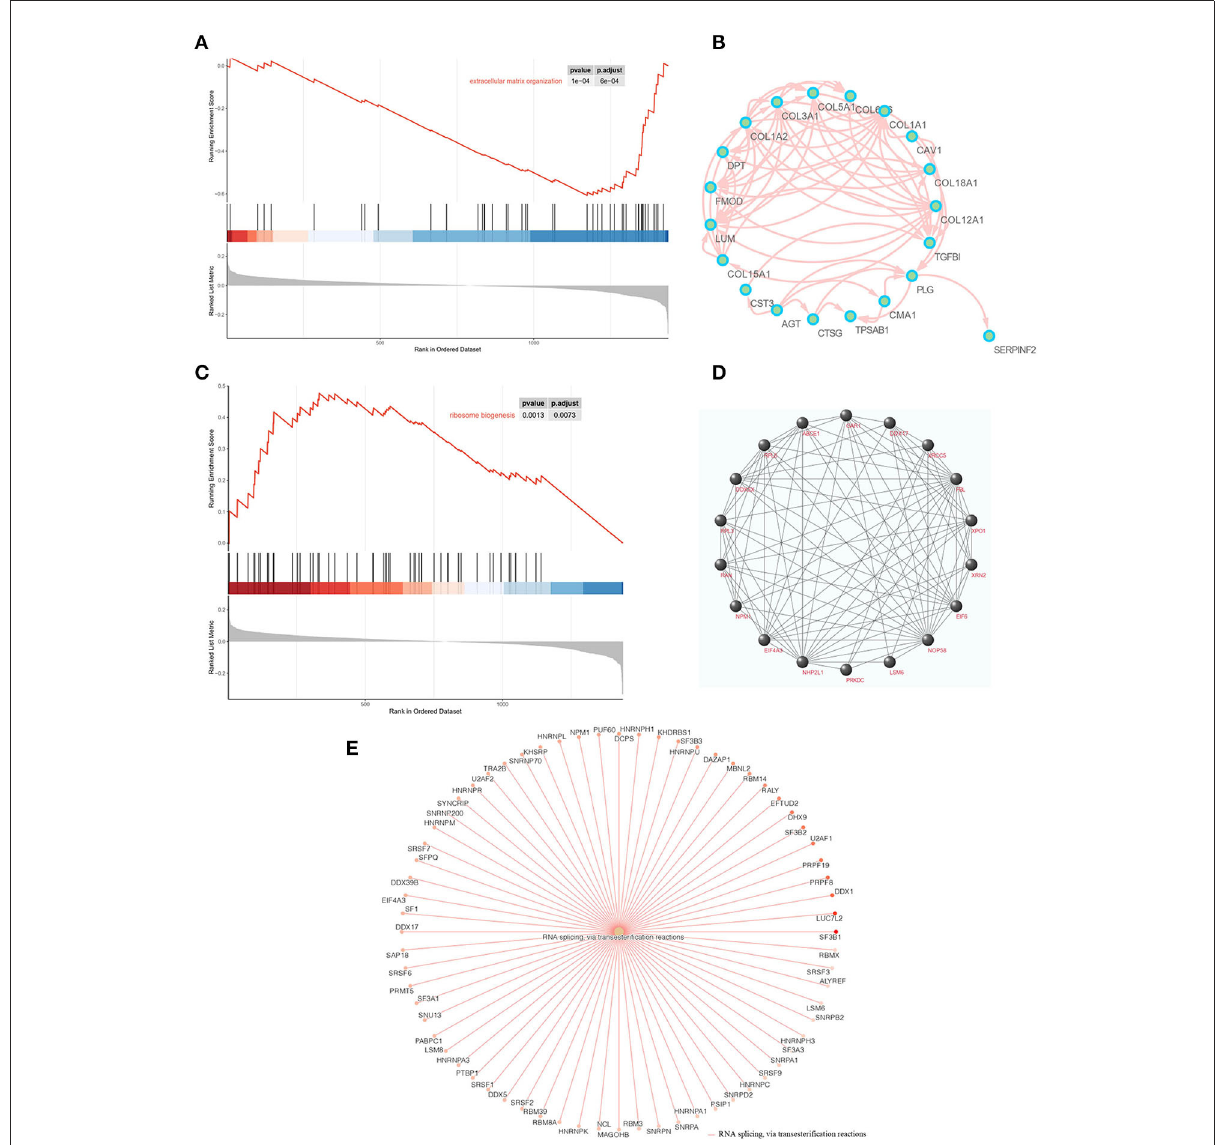
FIGURE6 (A) GSEA enrichment plots of the downregulation of ECM organization in ACC. (B) PPI networks of downregulated biomarkers of ECM organization using STRING v11.5. (C) GSEA enrichment plots of the upregulation of ribosome biogenesis in ACC. (D) PPI networks of upregulated biomarkers of ribosome biogenesis using STRING v11.5. (E) GSEA enrichment networks of the upregulation of RNA splicing in